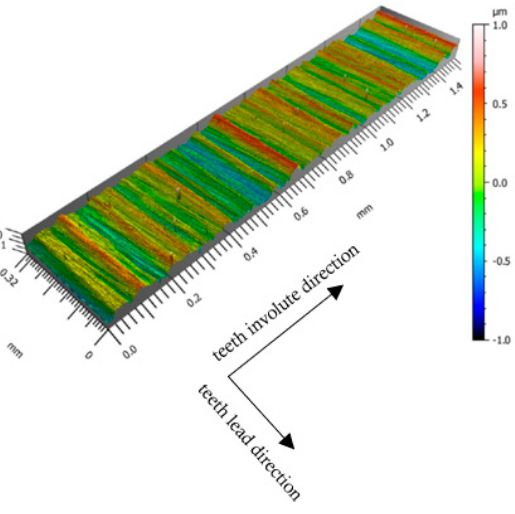
Figure 10. Visibility of the tooth flank after teeth grinding process.